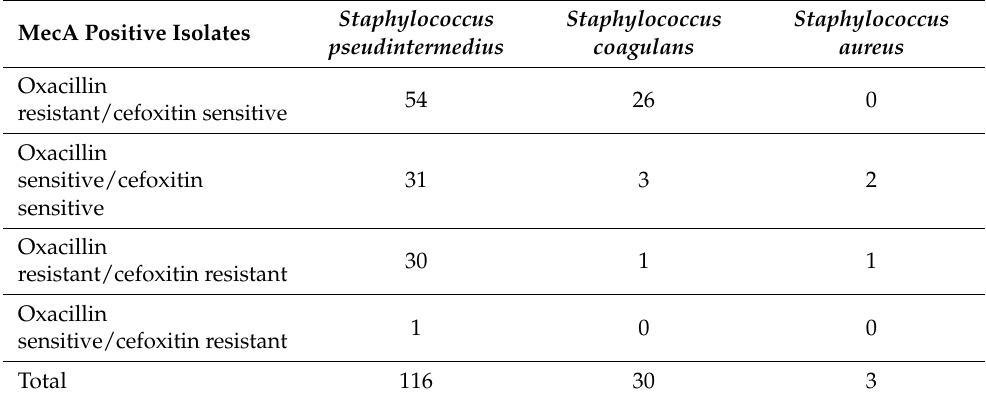
Table 2. Phenotypic resistance to oxacillin and cefoxitin of mecA positive Staphylococcus strains. MecA Positive